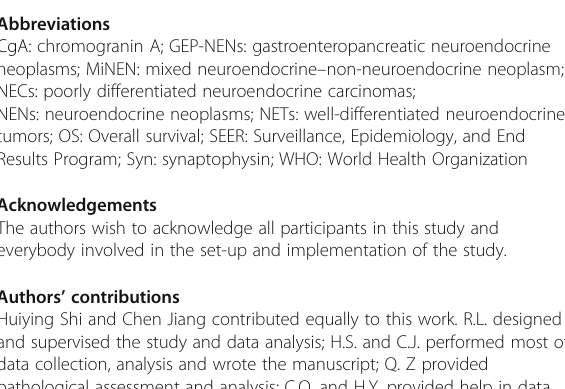
Additional file 1: Supplementary Table 1. CgA, Syn and grading in patients between primary and metastatic